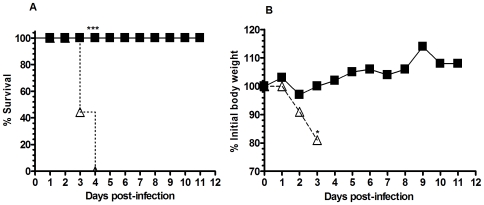
Survival of PCN and PBS-treated mice following challenge with SARS-coronavirus.A). All PCN-treated mice (▪) survived infection with SARS-coronavirus whereas all of the PBS-treated control mice (Δ) were dead by day 4 post-infection; ***, P<0.001. B) PCN-treated mice (▪) maintained their body weight following SARS-coronavirus infection whereas PBS-treated control mice (Δ) lost significant amounts of body weight shortly after infection.